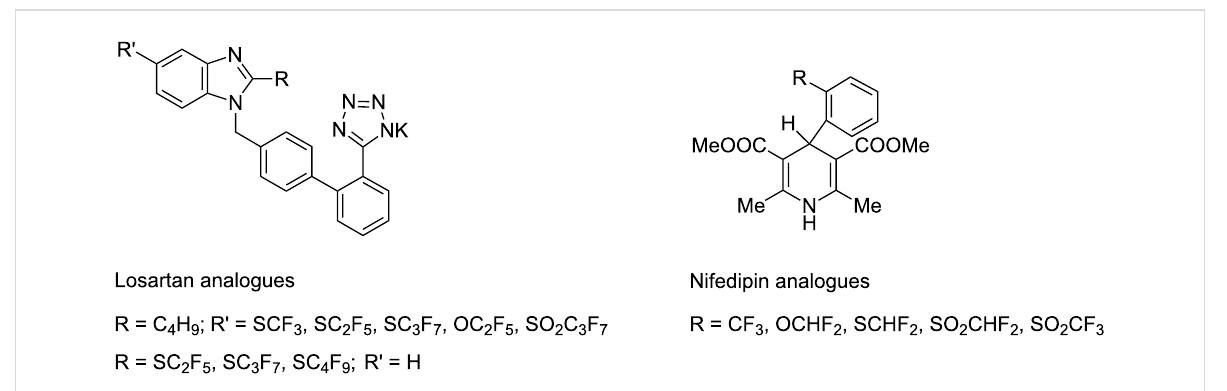
Figure 2: CF 3 (S)- and CF 3 (O)-containing pharmacologically active